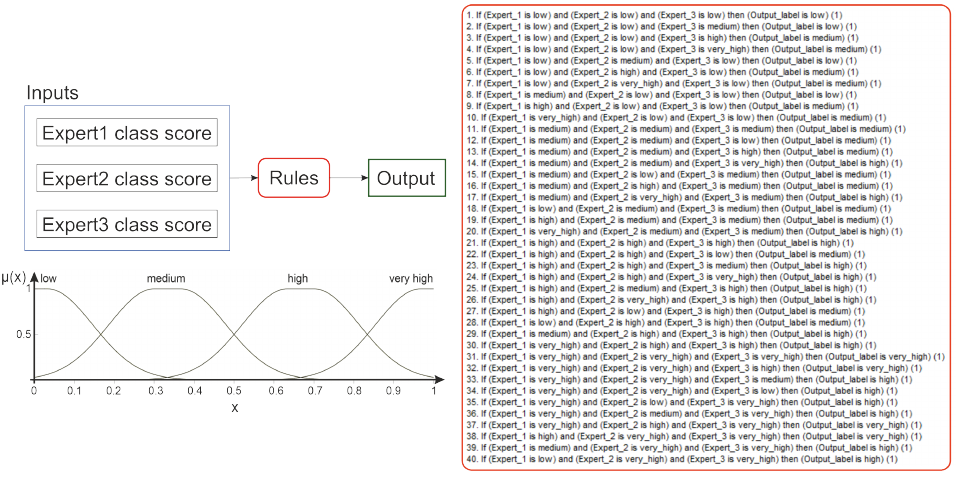
Figure 7. Fuzzy Interference System.